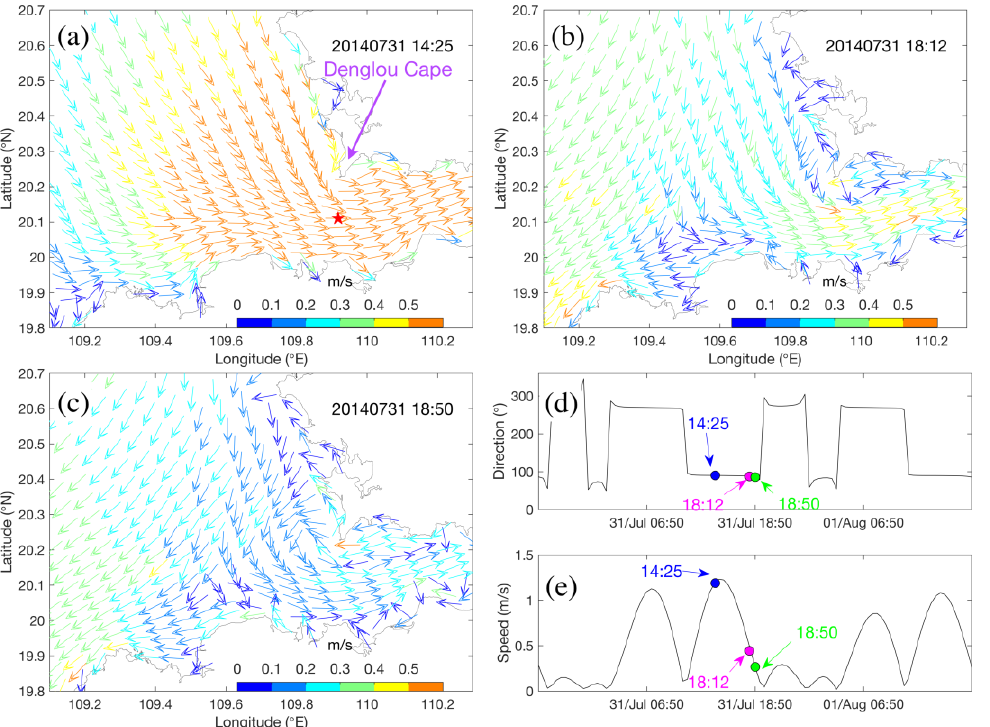
Figure 10. ( a – c ) Tidal current fields accompanying those events shown in Figure 9, respectively. Time series of tidal current direction ( d ) and magnitude ( e ) at a representative point (red star in ( a )), three observing times are marked off with dots in different colors.